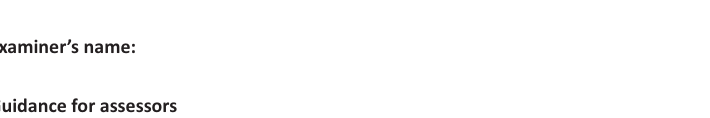
FIGURE 2: Marking template for consultation